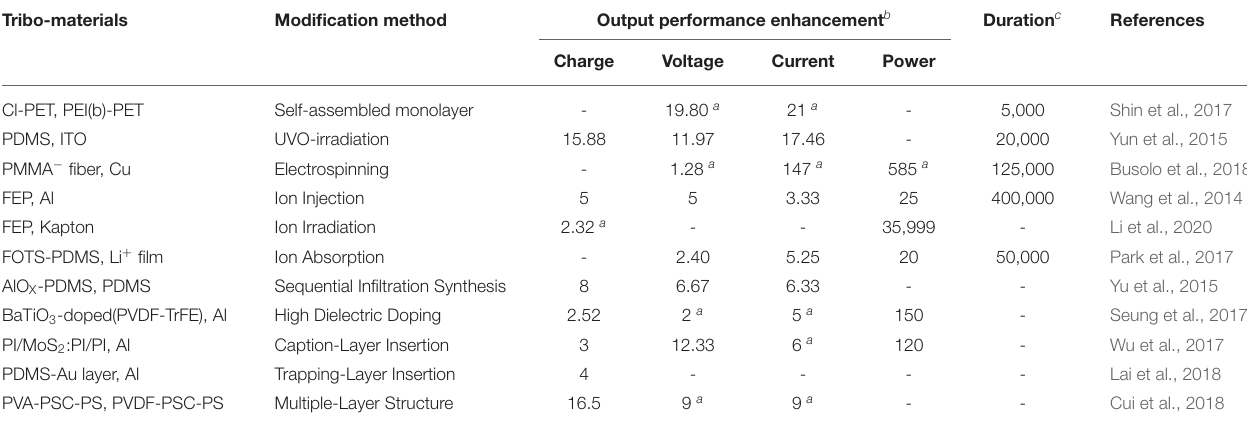
TABLE 1 | A summary of typical chemical modification methods for TENGs.